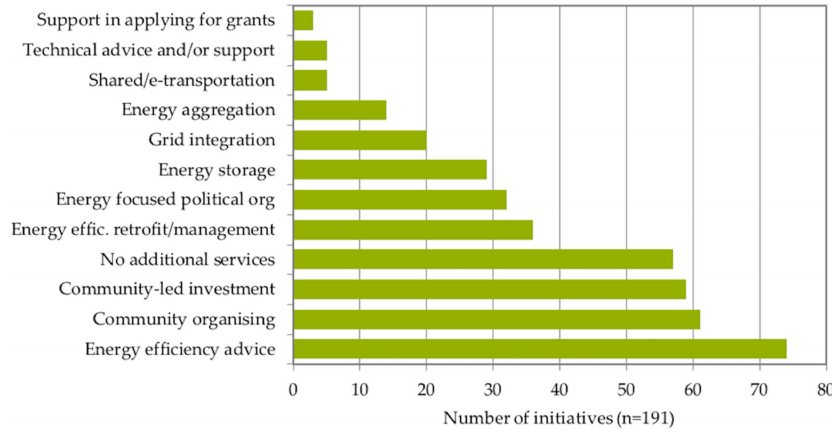
Figure 13. Additional services o ff ered by prosumer initiatives.